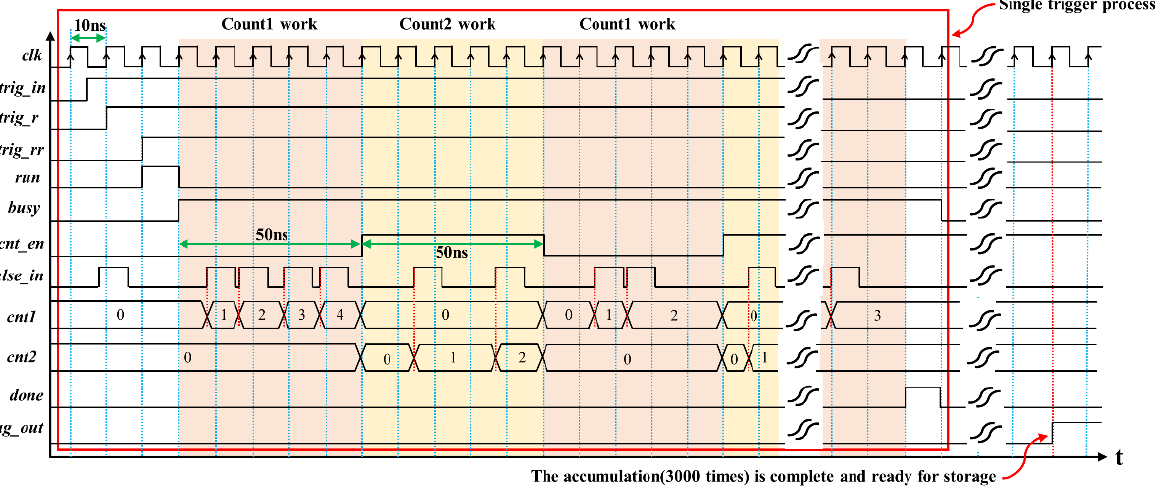
Figure 8. Main logic signal diagram of the acquisition system.